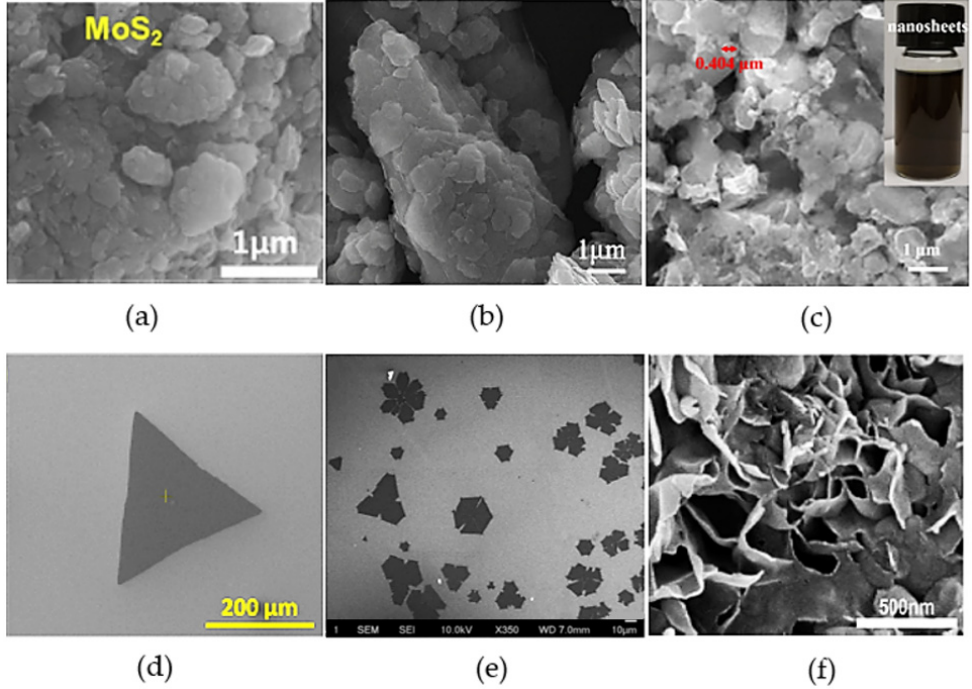
Figure 2. Electron microscopy images of MoS 2 , synthesized using different methods: ( a ) Ball- milling method. Reprinted from [78]. Copyright (2018), with permission from Elsevier. ( b ) Ball- milling method. Reprinted from [79]. Copyright (2020), with permission from Elsevier. ( c ) Liquid phase exfoliation method. Reprinted from [80]. Copyright (2019), with permission from Elsevier. ( d ) Chemical vapor deposition method. Reprinted from [81]. Copyright (2021), with permission from Elsevier. ( e ) Chemical vapor deposition method. Adapted from [82]. Copyright (2020), with permission from Elsevier. ( f ) Hydrothermal method. Reprinted from [83]. Copyright (2019), with permission from